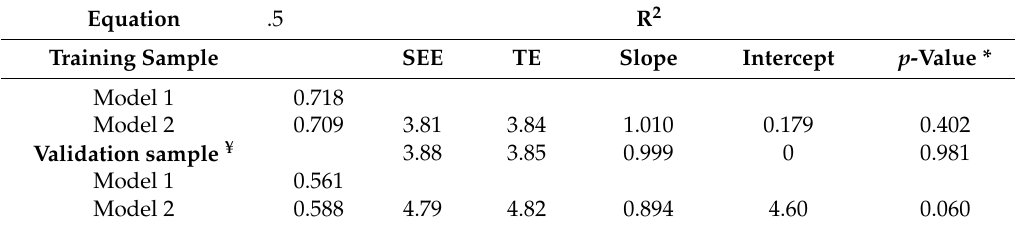
Table 3. Indicators for model performance in the training and validation samples. Equation